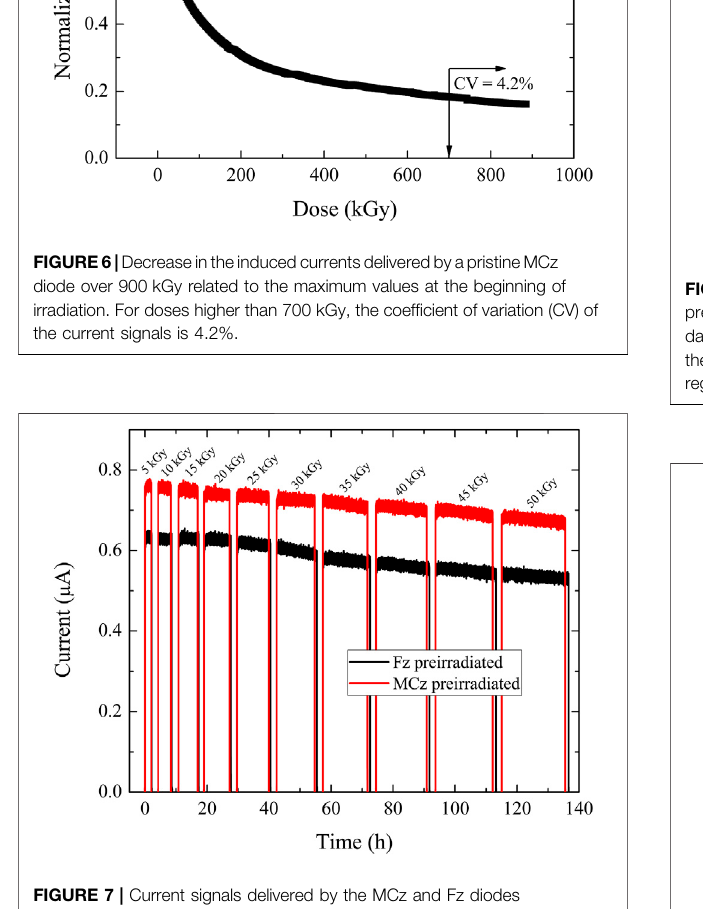
Frontiers in Sensors |